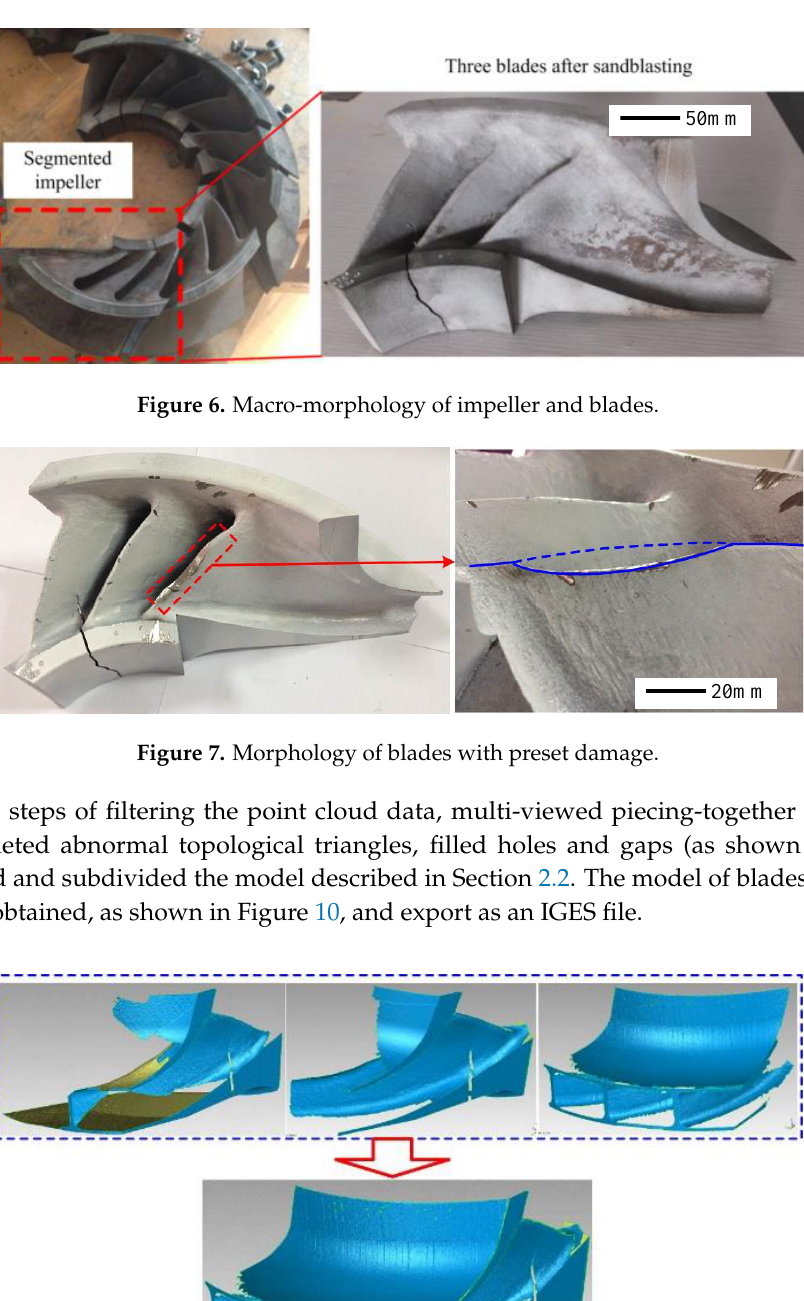
Figure 8. Schematic diagram of multi-viewed piecing-together.